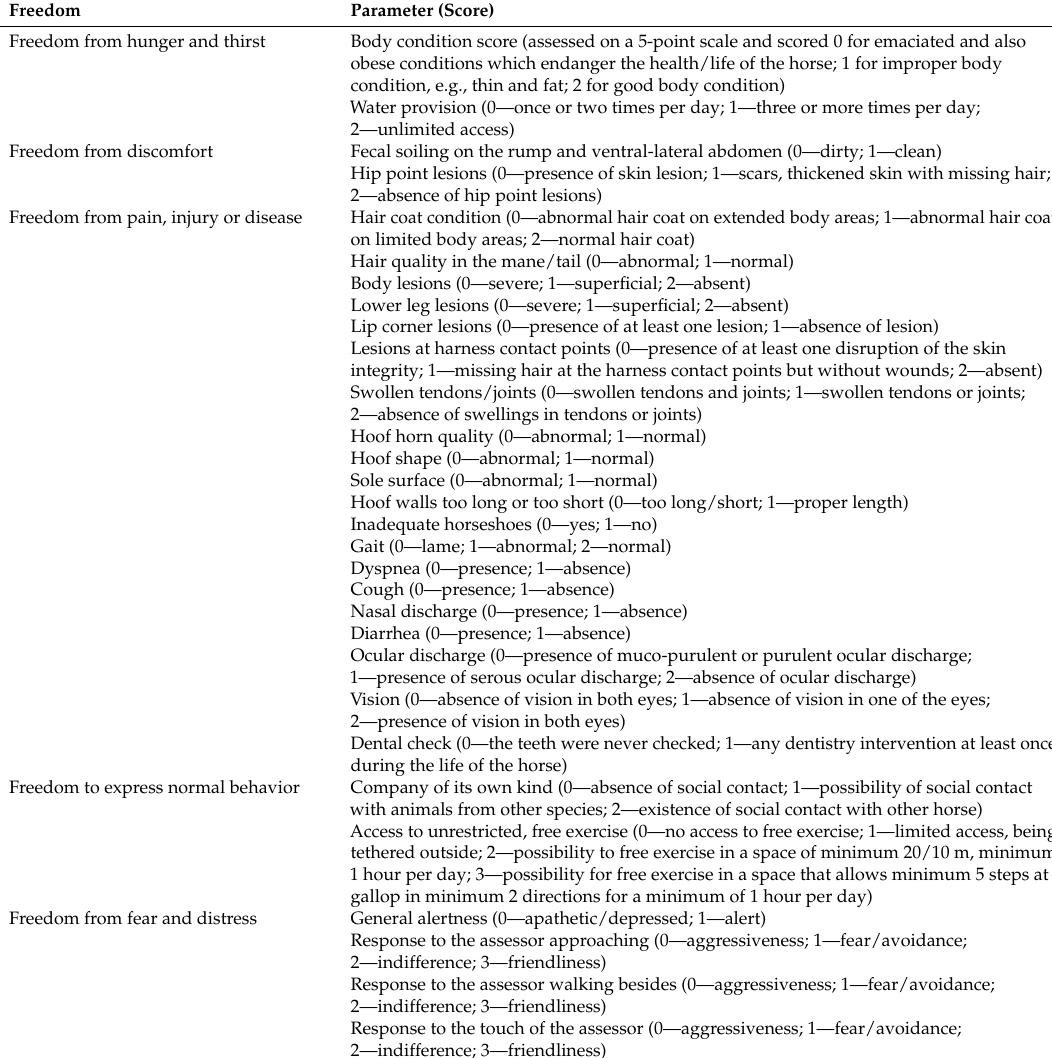
Table 1. The welfare parameters assessed for each of the five freedoms and the scores given [14]. Freedom Parameter (Score) Freedom from hunger and